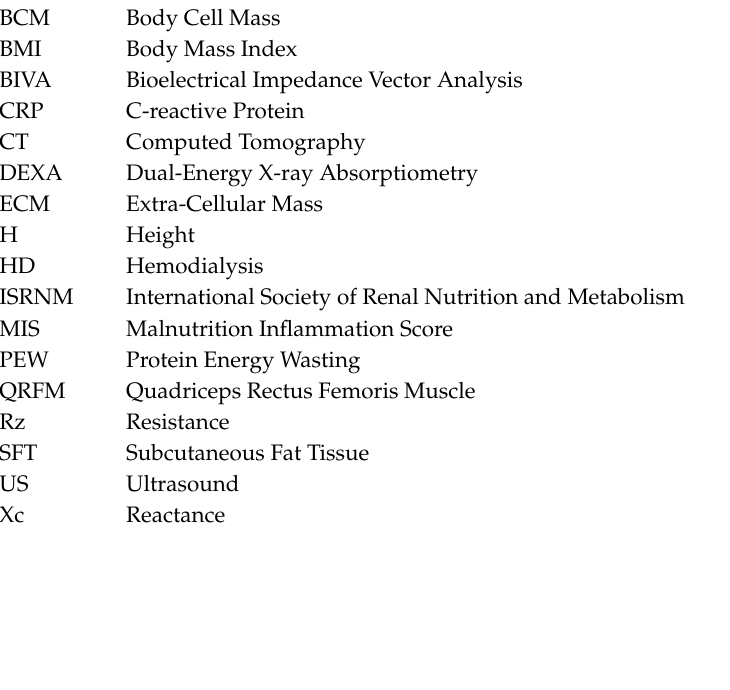
Figure S1: Correlation between QRFM thickness and BIVA parameters, Correlation between Abdominal SFT thickness and BIVA parameters, Table S1: Clinical metabolic and nutritional data of hemodialysis patients stratified by BMI, albumin and MIS score, Table S2: Correlation between BIVA parameters and nutritional indexes (MIS score, albumin and BMI) in HD